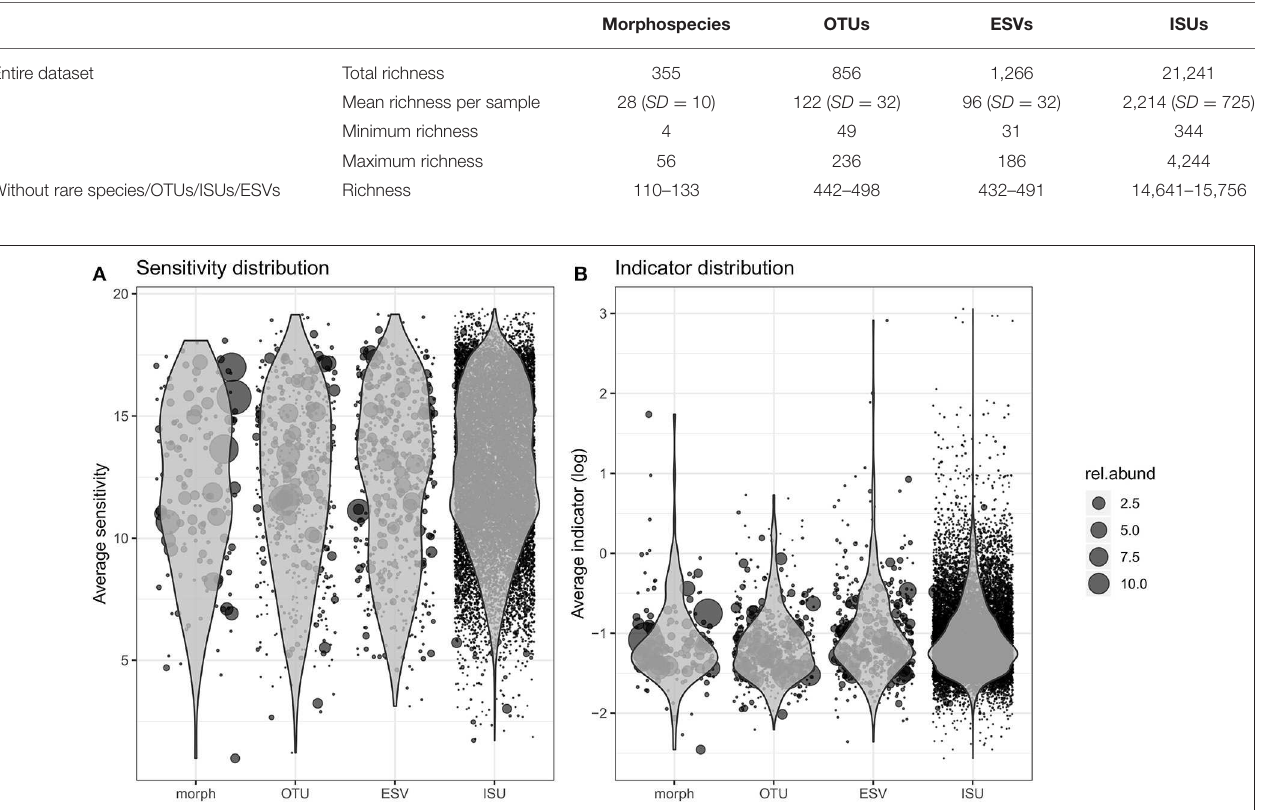
FIGURE 3 | Distribution of the sensitivity (A) and indicator (B) values estimated for each morphospecies, OTU, ESV, and ISU during the training procedure. The position of each dot corresponds to its average sensitivity/indicator values (over 100 estimates) and the size indicates its relative abundance.